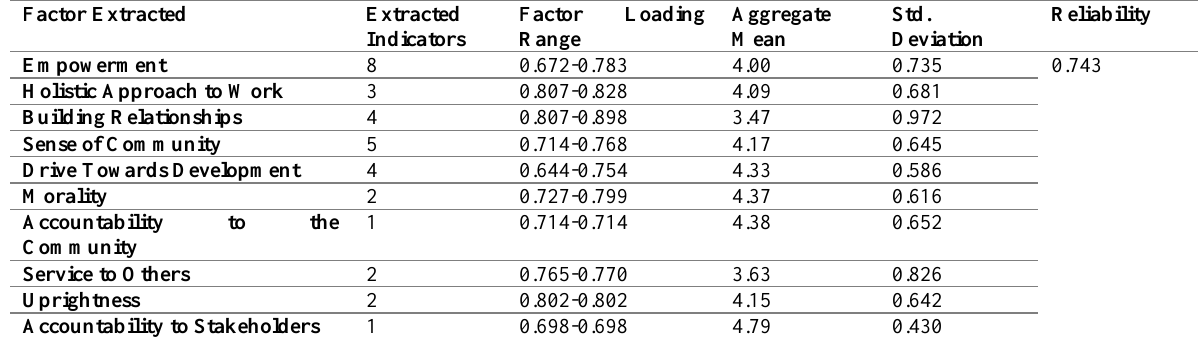
Table 3: Servant Leadership Extracted